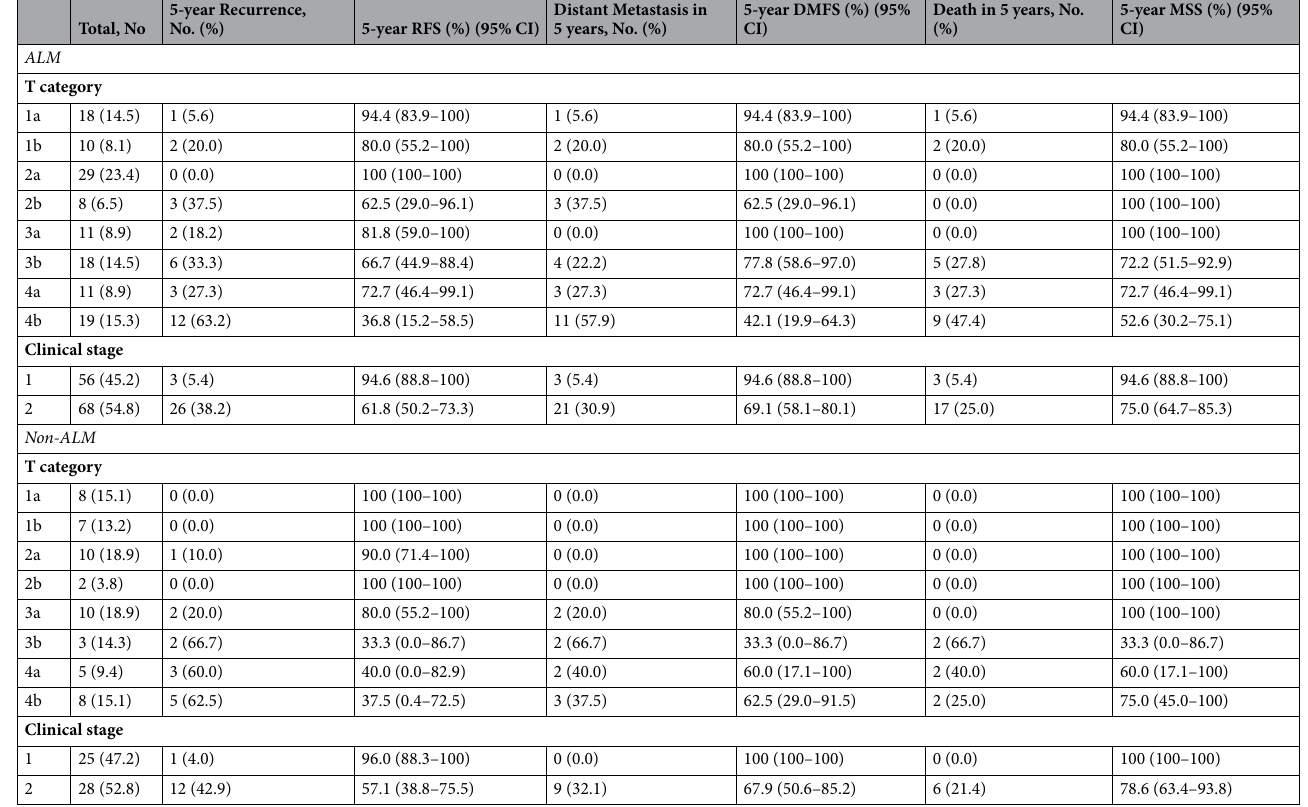
Table 4. Five-year recurrence-free survival, distant metastasis-free survival, and melanoma-specific survival in ALM and non-ALM patients. RFS recurrence-free survival, DMFS distant metastasis-free survival, MSS melanoma-specific survival.